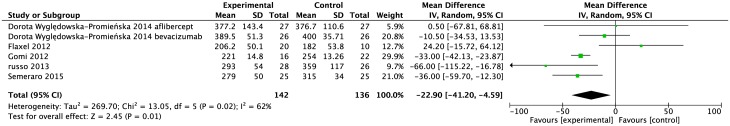
Forest plot showing weighted mean difference of CRT comparing combined treatment and anti-VEGF alone using the random effects model.